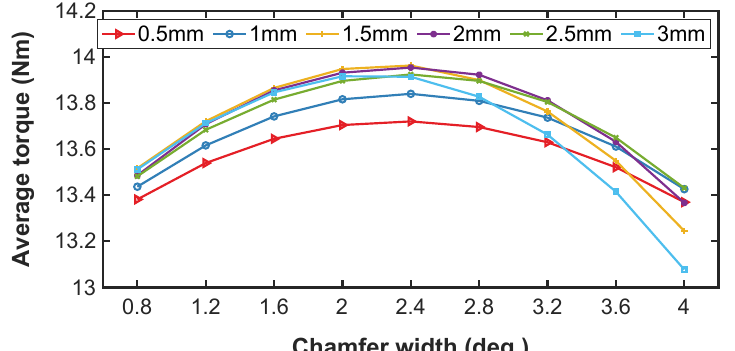
Figure 15. Relationship between chamfer shape and average